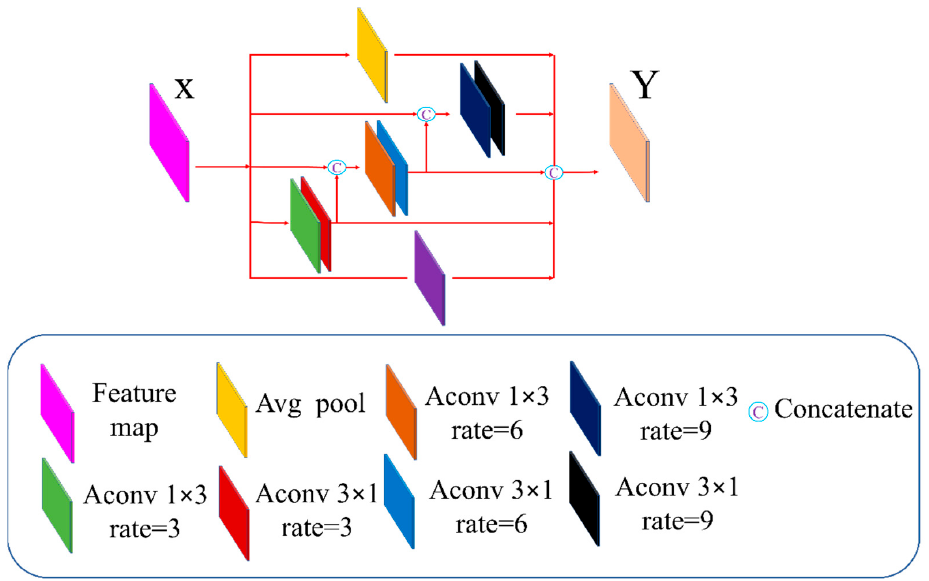
Figure 4. The structure of the optimized ASPP